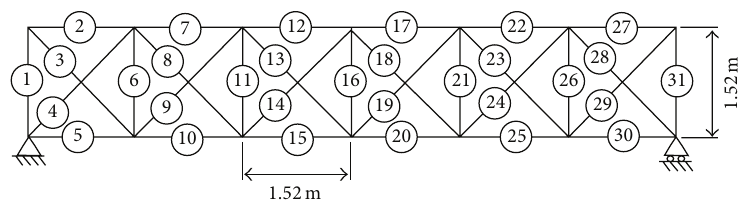
Figure 2: Planar truss having 31